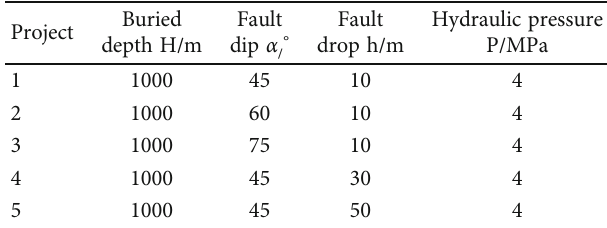
Table 1: Simulation design